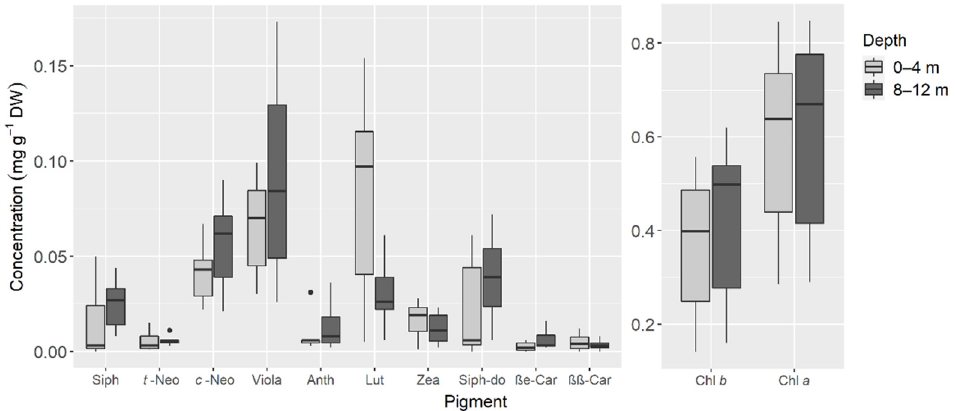
Figure 3. Concentration of photosynthetic pigments from samples of Elysia crispata collected at 0–4 m ( n = 7) and 8–12 m ( n = 7) depth, in the Southern Gulf of Mexico. The line represents the median, top and bottom of the box are the 25th and 75th percentiles. The whiskers represent the maximum and minimum values, and dots are outliers. See Table 1 for full names and respective abbreviations of pigments.